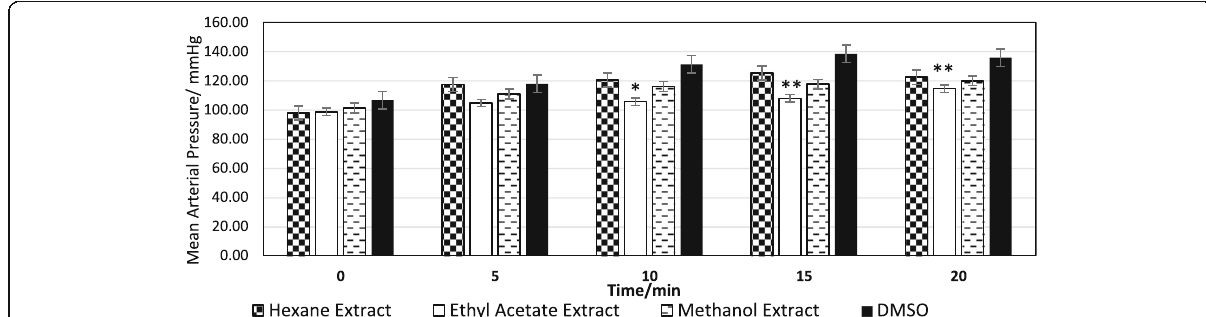
Fig. 5 The effects of the crude extracts of D. canum on the mean arterial pressure of normal Sprague-Dawley rats (IV @ 50 mg/kg BW). * p < 0.05. ** p <